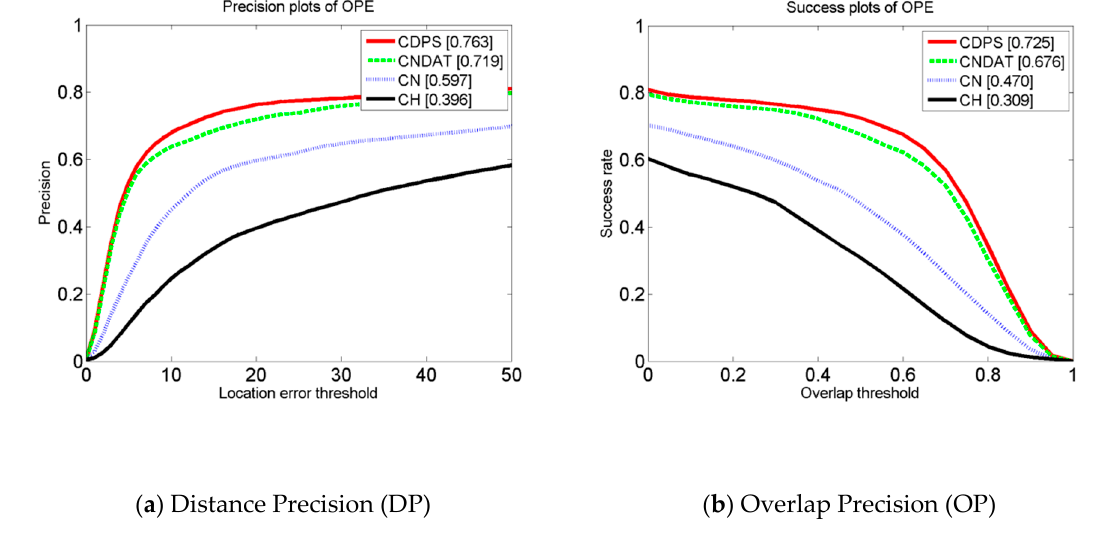
Figure 4. Feature comparison chart.